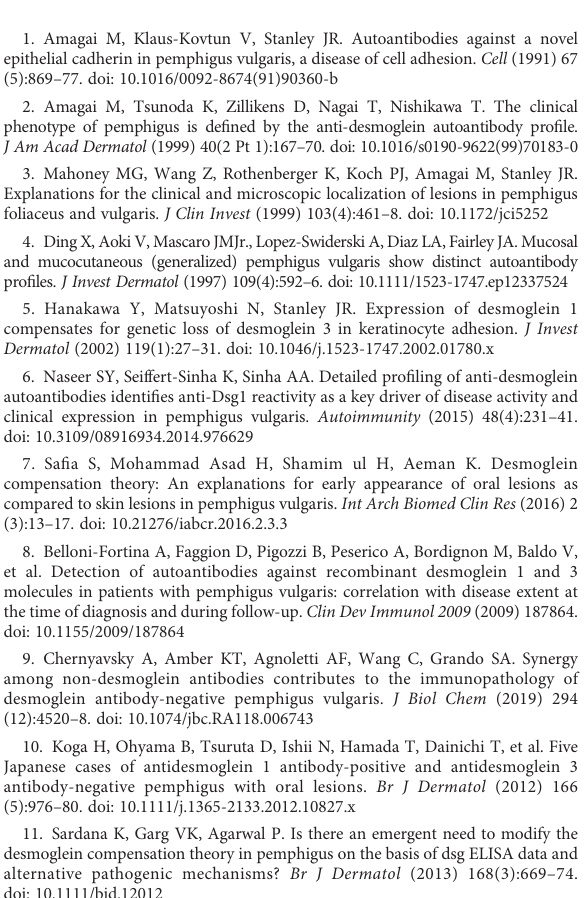
SUPPLEMENTARY FIGURE 1 Anti-Dsg Levels Across Treatment Status. Anti-Dsg3/1 levels in patients are shown based on level of therapy in active disease (A) , partial remission (B) , and complete remission (C) . SUPPLEMENTARY FIGURE 2 Anti-Dsg Levels Across Disease Activity. Anti-Dsg1 levels (A) and anti- Dsg3 levels (B) are shown across varying levels of disease activity in patients as well as in the healthy control group. SUPPLEMENTARY FIGURE 3 Contradictions intheDHCobservedinactivepatients.Themostcommon contradiction to the DCH observed in active PV is the cutaneous only variant of disease (cPV) (green shading in left column at a cut-off of 10 IU/ ml, 20 IU/ml, and 36/37 IU/ml). A breakdown of contradictions within the cutaneous only manifestation of PV (right column) identi fi es all possible combinations of anti-Dsg3/Dsg1